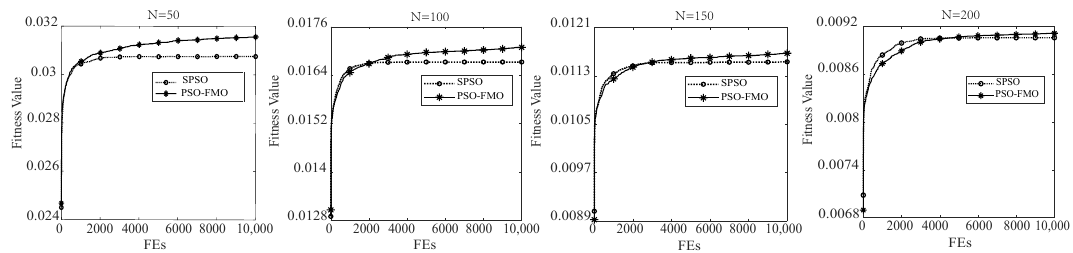
Figure 6. Mean convergence curves of SPSO and PSO-FMO in optimizing sensor node clustering.